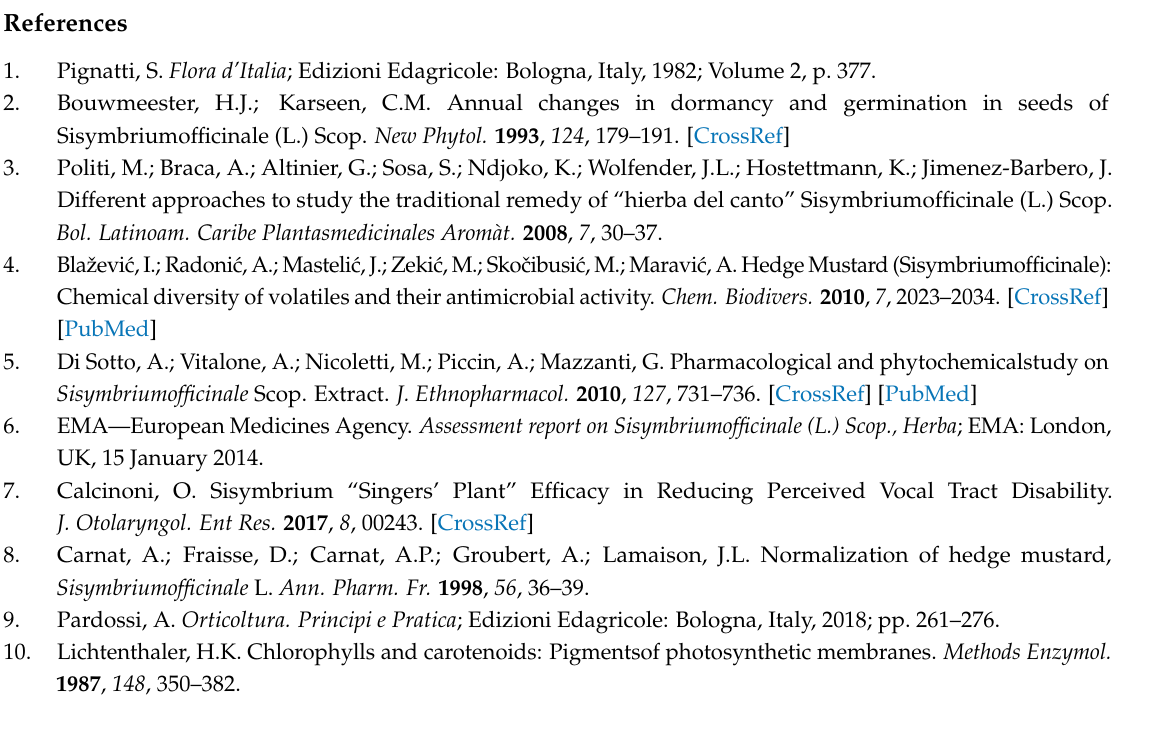
Figure S1: Temperature minimum and maximum and solar radiation (RG) during the cultivation period, Table S1: Cultivation period including sowing, transplanting, sampling, and harvest